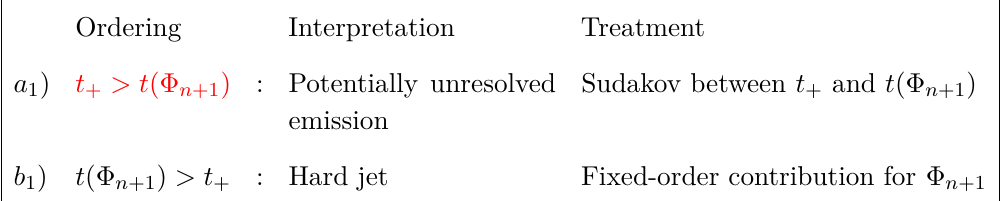
Table 6 . Possible evolution variable orderings for one-parton states. For e + e − → jets, only the ordering in red applies, while any ordering is possible for generic hadron-collider